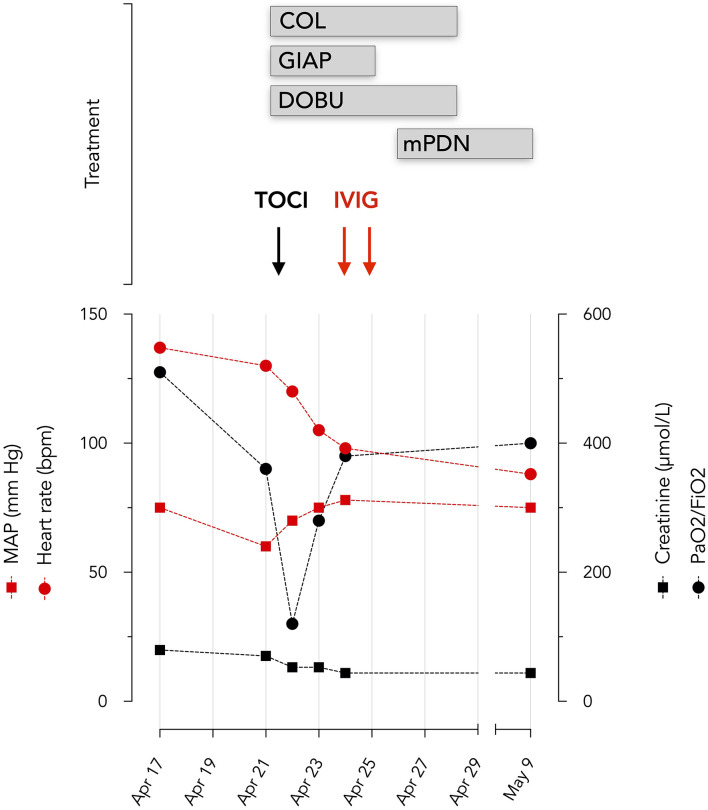
Evolution of hemodynamic and organ function variables. Oxygenation was assessed by PaO2/FiO2 ratio and renal function by serum creatinine levels BPM beats per minute. TOCI, tocilizumab; COL, colchicine; DOBU, dobutamine; mPDN, methylprednisolone; IVIG, Privigen 60 g; GIAP, Giapreza.